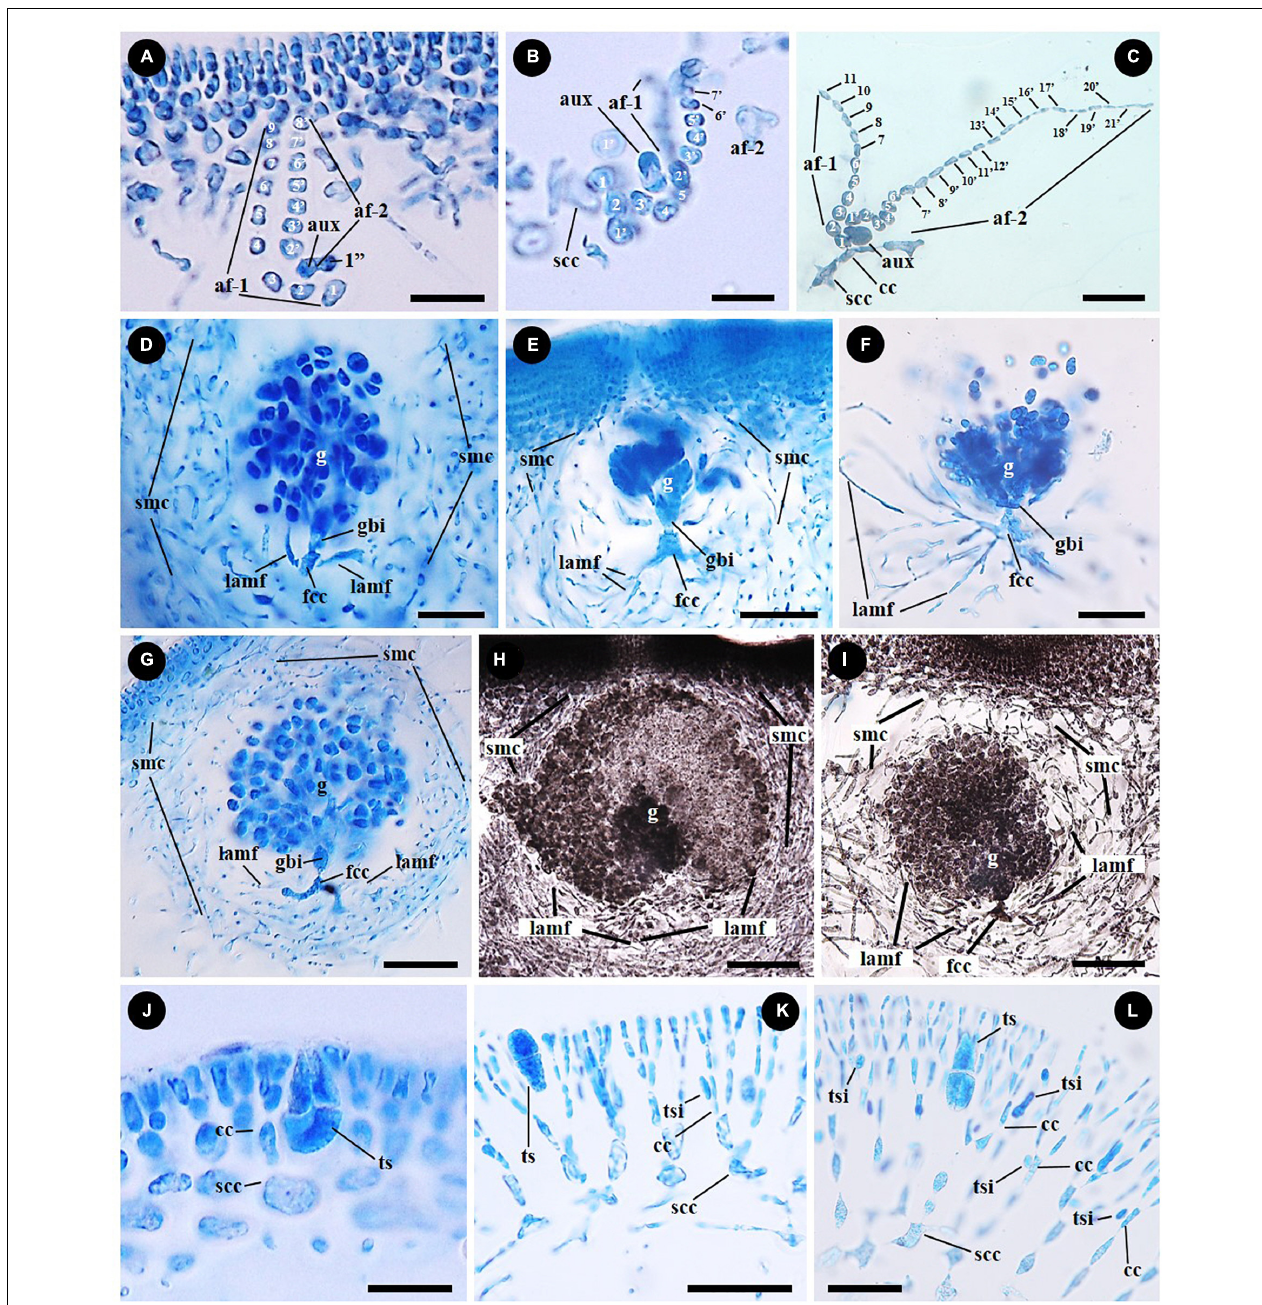
FIGURE 4 | Female reproductive structures and tetrasporangial development of representative species of the Grateloupiaceae: Grateloupia catenata (A,D,G,J) , “Grateloupia” jejuensis (B,E) , “G.” livida (H,K) , Pachymeniopsis elliptica (C,F) , and Pa. lanceolata (I,L) . (A–C) 2-ordered auxiliary cell ampullae originated from subcortical cell (scc) or inner cortical cell (cc) of the representative species G. catenata ( A , MSK180814-01), “ G.” jejuensis ( B , MSK170722-32) and Pa. elliptica ( C , MSK170417-57). Each auxiliary cell (aux) is the basal cell of a second order ampullary filament (af-2) borne from a first order cell (af-1). (D–F) Young gonimoblasts originated from fusion cell complex (fcc), the gonimoblast initial (gbi) and the elongation and branching of lateral ampullary filaments in the gonimolobe (g) in G. catenata ( D , MSK180814-01), “ G.” jejuensis ( E , MSK170722-37) and Pa. elliptica ( F , MSK170417-58). Lateral ampullary filaments (lamf) and secondary medullary cells (smc). (G–I) Pericarp composed of lateral ampullary filaments of a fusion cell complex (fcc) and secondary medullary filaments (smc) originated from the subcortex in G. catenata ( G , MSK180814-01), “ G.” livida ( H , MSK170417-67) and Pa. lanceolata ( I , MSK150502-05). Laterally entangled ampullary filaments and numerous secondary medullary filaments surrounding the gonimolobe (g). (J–L) Tetrasporangia (ts) cruciately divided, and tetrasporangial initial (tsi) originated unilaterally from inner cortical cell (cc) in G. catenata ( J , MSK180814-02), “ G.” livida ( K , MSK140224-22) and Pa. lanceolata ( L , MSK161126-01). Scale bars: (A,B) = 15 µ m; (C,D,L) = 25 µ m; (E–G,I,K) = 50 µ m; (H) = 100 µ m; (J) = 20 µ m.